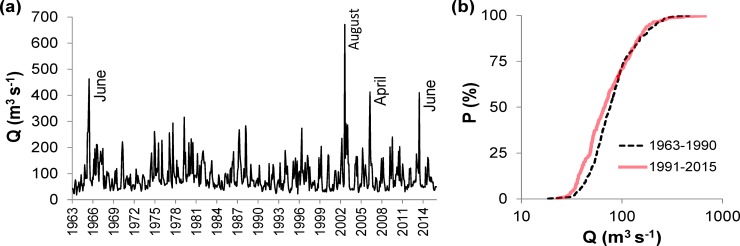
Monthly average water flow (Q) in the Slapy Reservoir.(a) Time-series of values during 1963–2015 (months with episodic high Q events are indicated) and (b) cumulative relative frequency distribution plots in 1963–1990 and 1991–2015.